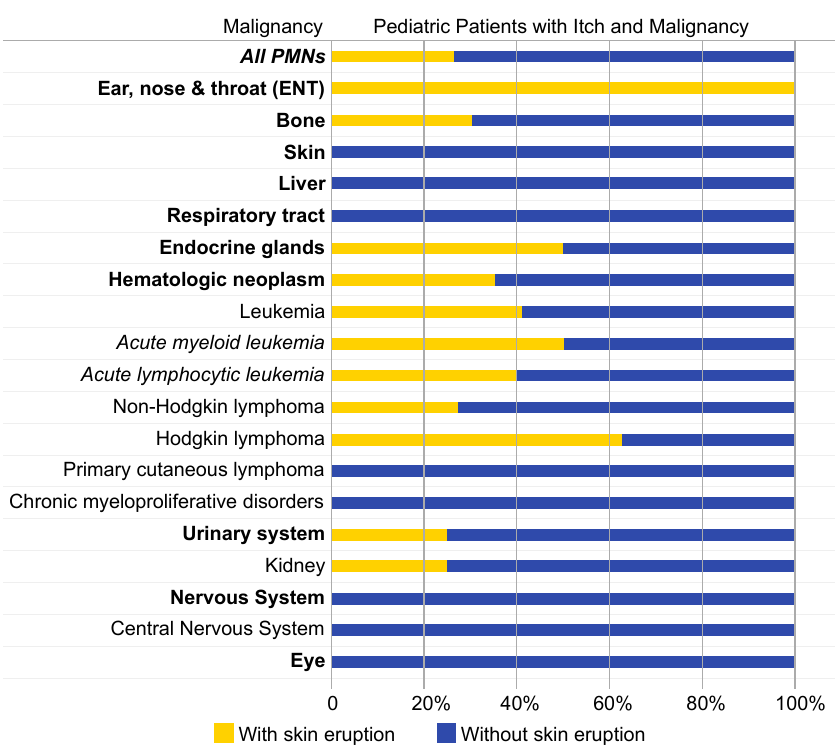
Figure 3. Prevalence of skin eruption in pediatric patients with itch and malignancy is variable. Lighter bars denote the percentage of patients with pruritus and a primary malignant neoplasm (PMN) who had a concurrent skin eruption. Darker bars denote percentage of patients with pruritus and a PMN without concurrent skin eruption.